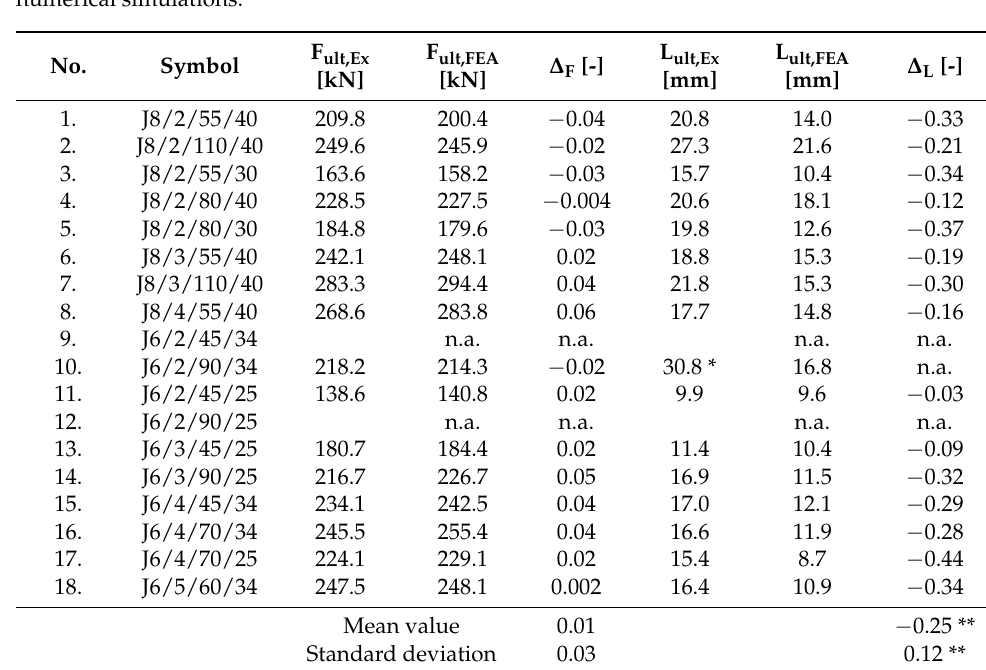
*: displacement measured by machine clamps. **: results excluding J6/2/90/34 element. n.a.: not analysed because of bolt